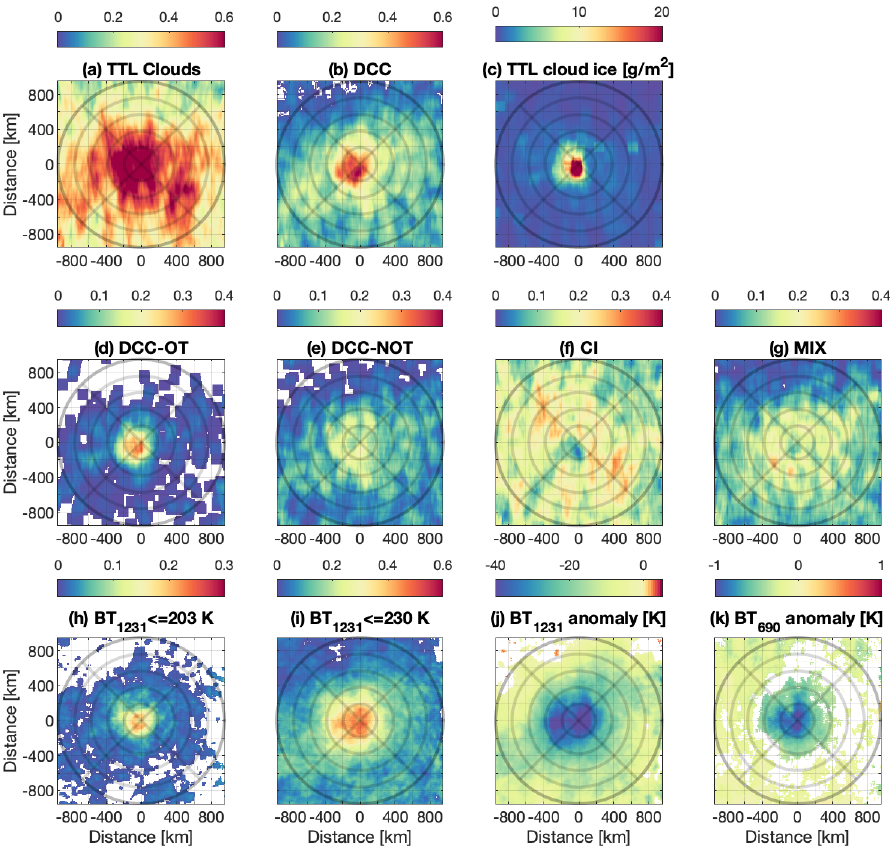
Figure 3. Cyclone-centered composite of cloud statistics. The occurrence frequency of (a) TTL clouds (i.e., clouds above 16km) and (b) deep convective clouds (regardless of TTL cloud occurrence). (c) Ice water path (g/m 2 ) above 16km. The occurrence frequency of four TTL cloud categories (defined in Sect. 3.1 and schematically shown in Fig. 2): (d) DCC-OT (overshooting DCCs), (e) DCC-NOT (non- overshooting DCCs), (f) CI (cirrus), and (g) MIX (remaining conditions). The occurrence frequency of clouds identified by infrared radiance measurements: (h) deep convective clouds with BT 1231 ≤ 203K and (i) overcast high clouds with BT 1231 ≤ 230K. Brightness temperature anomalies (K) in (j) an atmospheric window channel (BT 1231 ) and (k) a CO 2 channel (BT 690 ). Upper (a–c) , middle (d–g) , and lower (h–k) panels are based on data from DARDAR-Cloud-IWC, CloudSat 2B-CLDCLASS-LIDAR, and the AIRS L1B v5 product, respectively. Only statistically significant occurrence frequencies (at a 99% confidence level, compared to zero) are shown in (a, b, d–i) , and only significant brightness temperature anomalies (99%, compared to the climatology) are shown in (j, k)